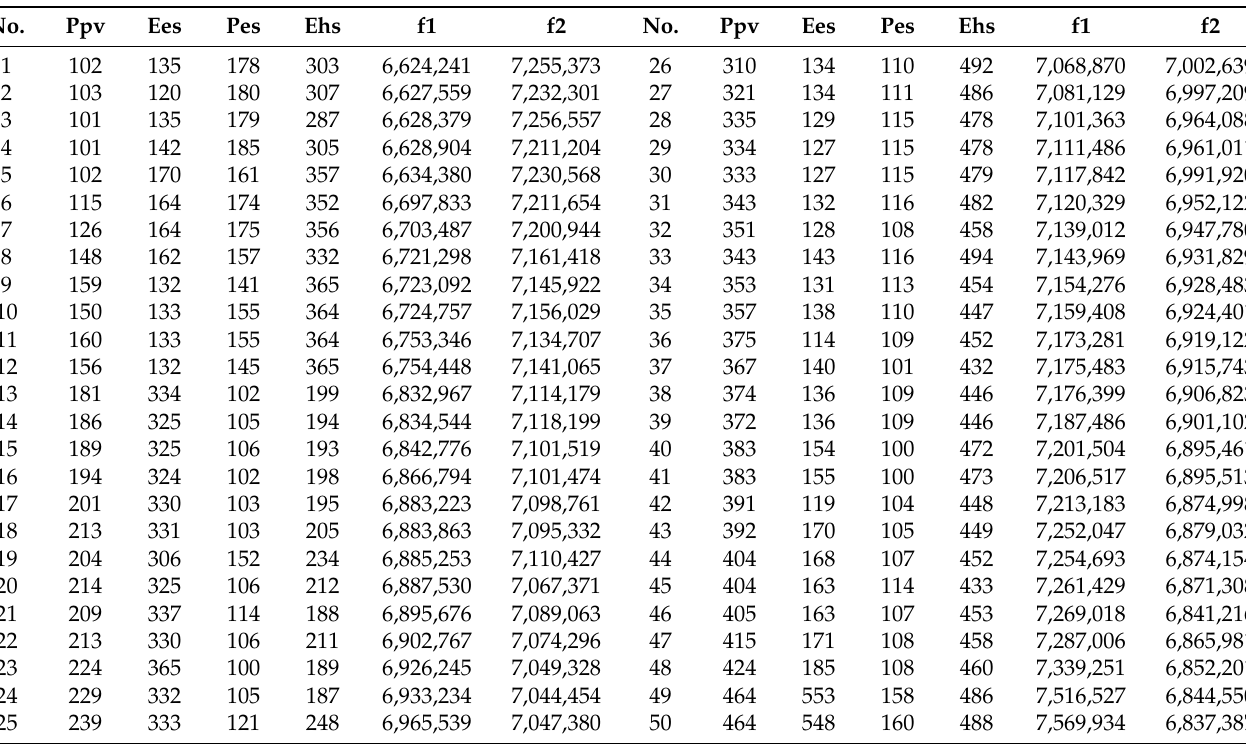
Figure 12. ( a ) Pareto frontier; ( b ) comprehensive evaluation index of each solution. Table 4. Pareto solution